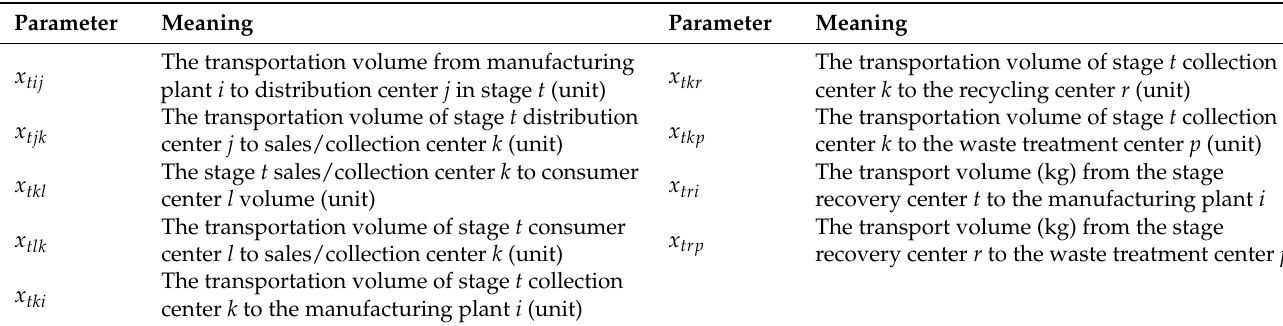
Table 10. Transportation decision variables.